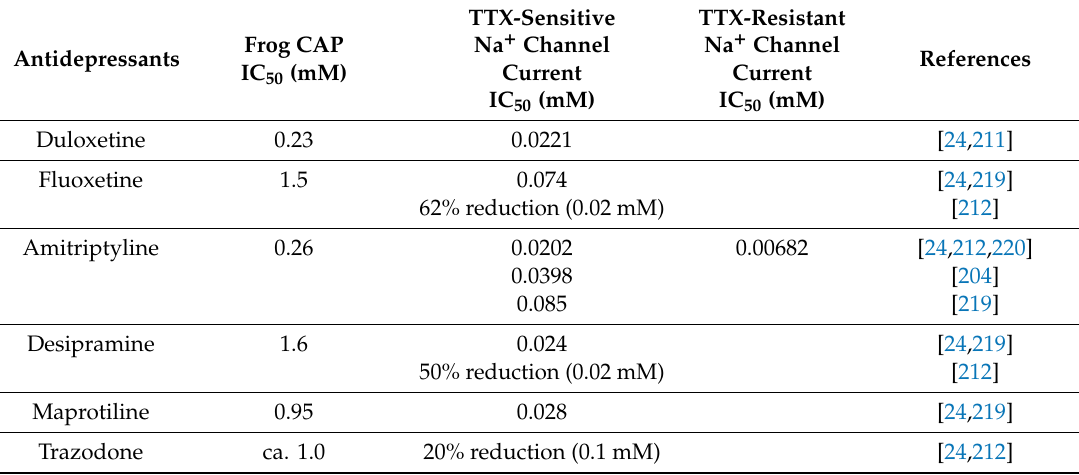
Table 5. Comparison of IC 50 values in inhibiting frog sciatic nerve fast-conducting CAPs and TTX-sensitive or -resistant Na + channels among